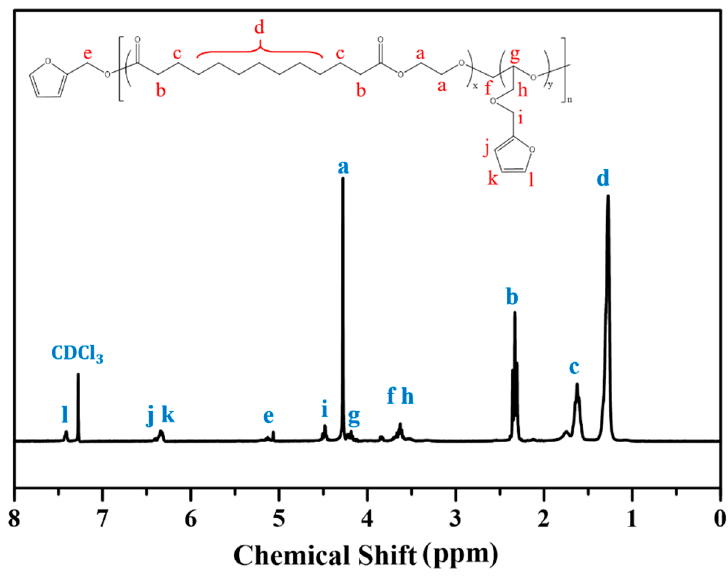
Figure 2. 1 H-NMR spectrum of the synthesized PEBF copolymer in CDCl 3 .